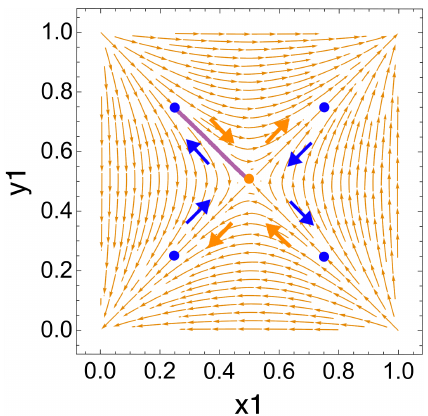
Figure 10. Directional framework for market influenced dynamics with normalized bear market payoffs. Directional dynamics are presented through the lens of a normalized n = 0 payoff. The attractor position at n = 0 is represented in orange. Four theoretical attractor positions at n = 1, represented in blue, are depicted in quadrants I through IV. Directional dynamics during bear and bull markets are represented by the orange and blue arrows, respectively. A single attractor arc is illustrated in purple to demonstrate when the attractor position at n = 1 is located in quadrant II in respect to a normalized attractor position at n = 0. Here, directional dynamics are similar to our first theoretical example, see Figure